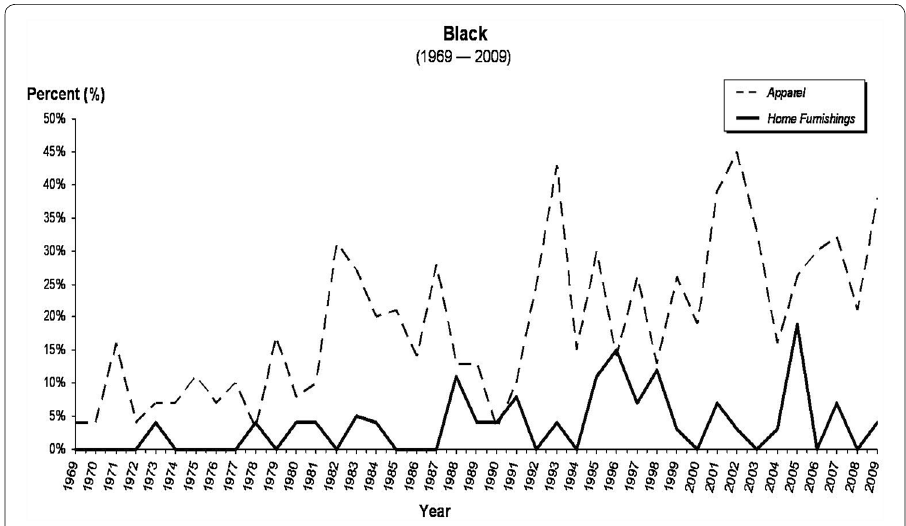
Fig. 9 Black: incidences of black in home furnishings and apparel